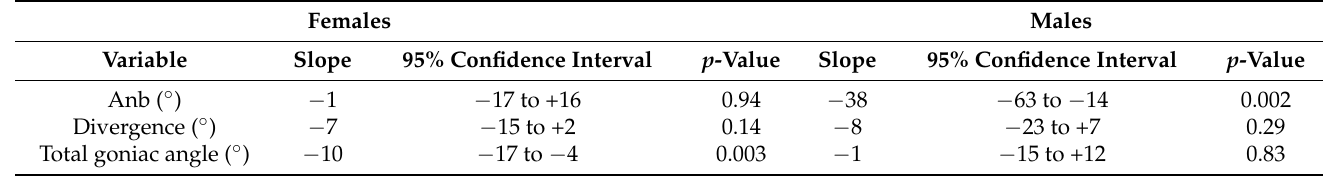
Figure 4. Condylar volume values (mm 3 ) in relation to selected continuous variables: divergence (°) ( A ) and Total goniac angle (°) ( B ), by gender. Observed (circles) and crude, predicted, random-intercept linear regression lines. Females: black circles and solid lines; males: empty circles and dashed lines. Table 2. Condylar volume values (mm 3 ) in relation to selected, continuous variables, by gender.